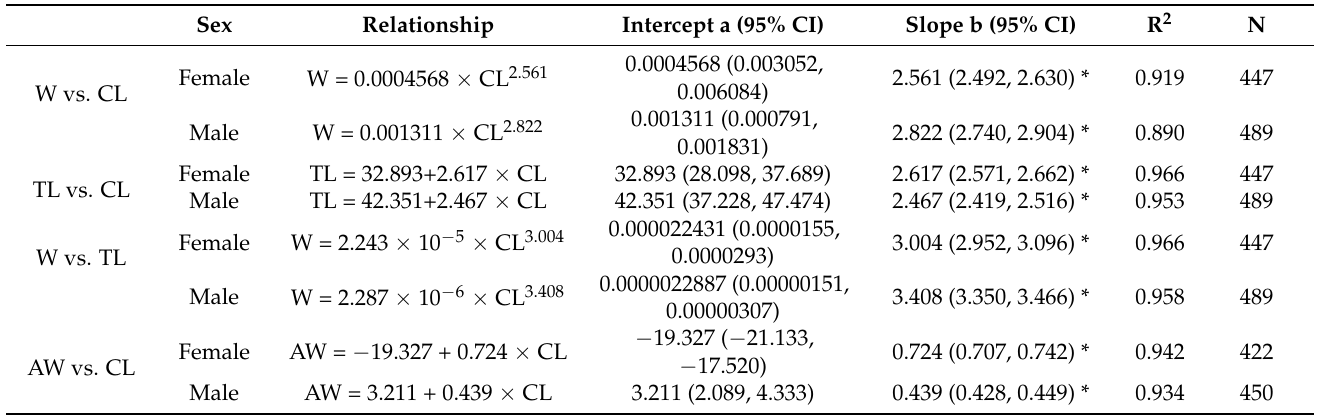
Figure 5. Variation in CL ( A ), TL ( B ), and W ( C ) (mean ± standard deviation) of female and male European lobster by fishing zone. CL, carapace length; W, weight; and TL, total length. Parameters of ordinary least-squares regressions between males and females of the European lobster ( Homarus gammarus